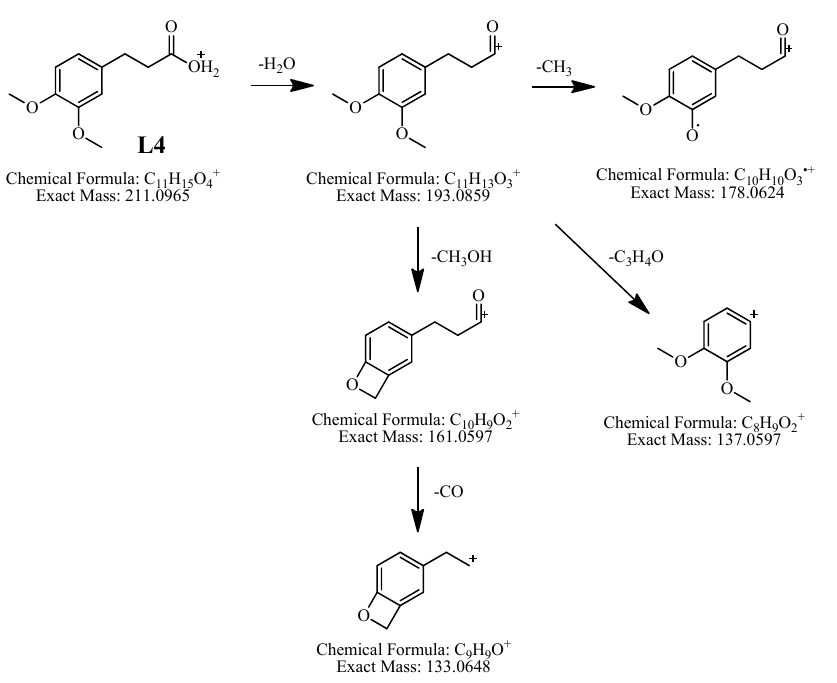
Figure 7. Proposed fragmentation pathways of 3,4-dimethoxybenzenepropionic acid ( L4 ) in positive ion APCI-MS.